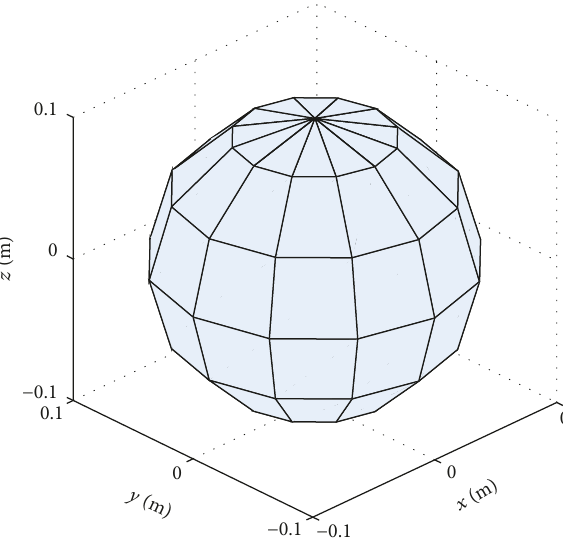
Figure 12: The nodes distribution on the source surface of the pulsating